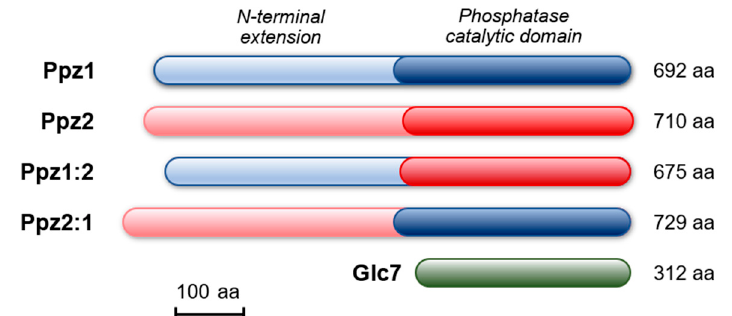
Figure 1. Cartoon depicting the structure and size of Ppz1, Ppz2, the hybrid Ppz proteins and Glc7. Ppz1:2 denotes a construct composed of the N-terminus of Ppz1 and the C-terminus of Ppz2. Ppz2:1 indicates the opposite construct. The size of the native and recombinant proteins is indicated on the right and does not include the 1xHA epitope tag present in some constructs.